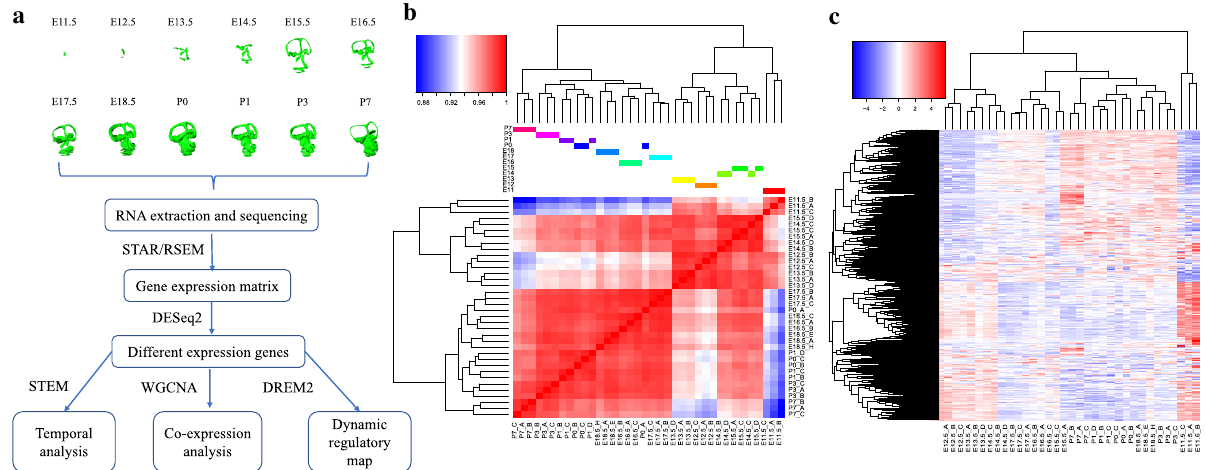
Figure 1. Study design and global gene expression profile. ( a ) The study design and analytical pipeline; ( b ) Pearson correlation between samples based on the overall expression profile; ( c ) Hierarchical clustering of DEGs and samples (FDR < 0.001 and |log2 fold-change|>